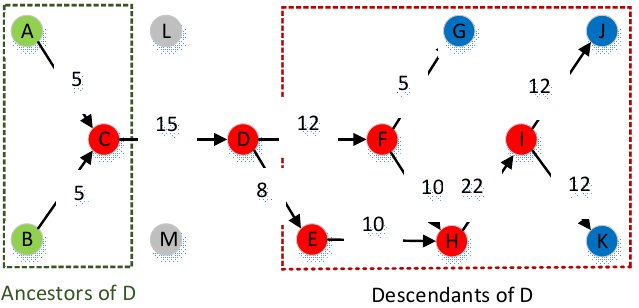
Figure 3. Example of a citation network.